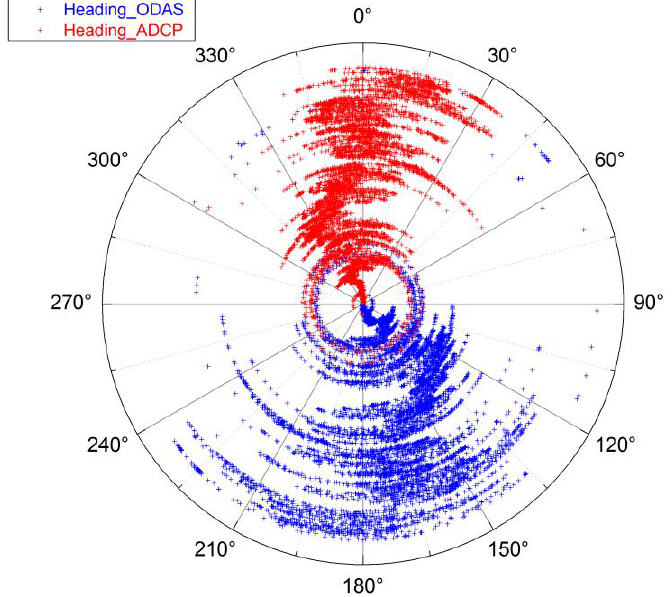
Figure 6. Heading values detected by buoy and ADCP in the period from 30 March to 29 August 2017.